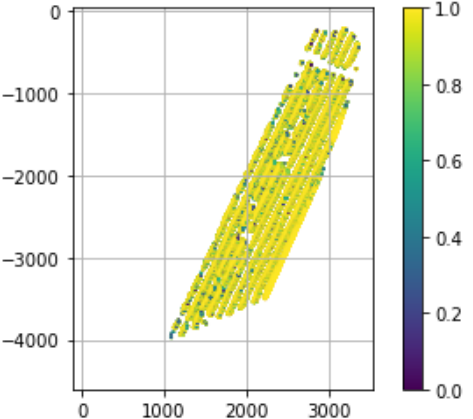
Figure 9. The FANSCAN object characteristic applied to the ( top right ) DSM data in Figure 4 at N v = 100 fan rasters per horizontal seed point. The color scale is in meters and negative pixel numbers are an artifact of the image to matrix conversion.